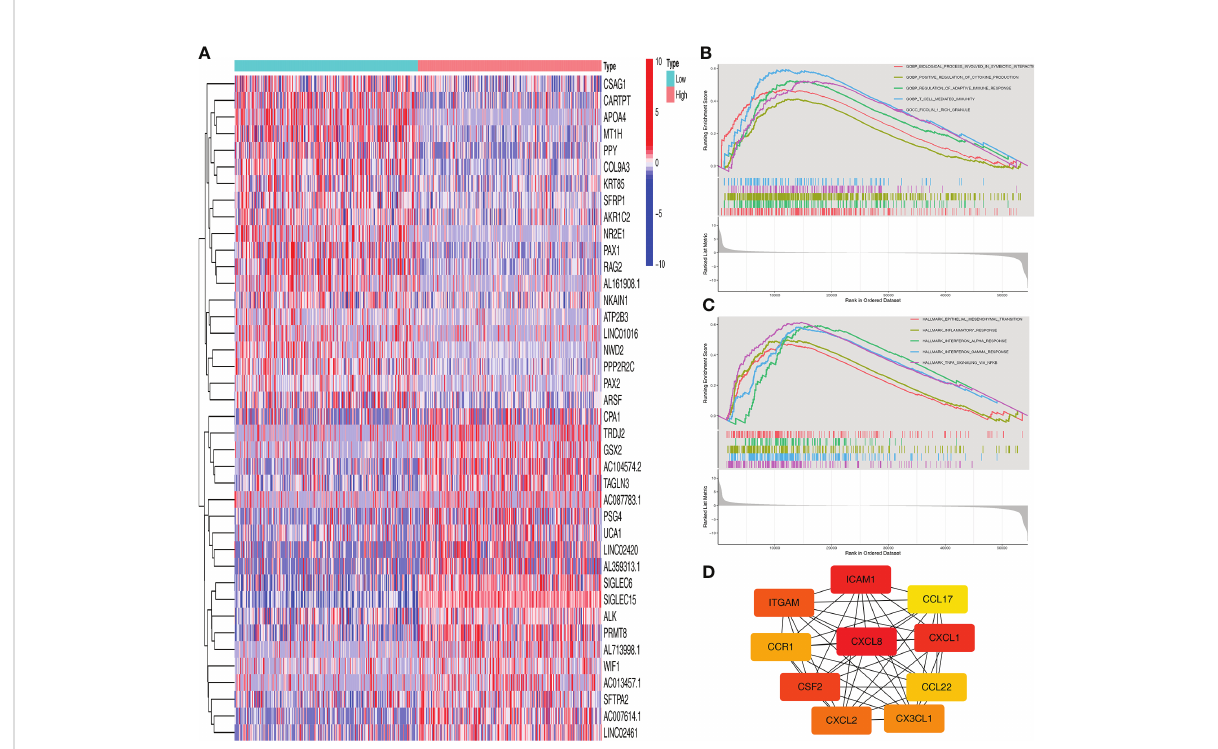
FIGURE 3 Functional enrichment analysis of SIGLEC15 . (A) Top 20 differentially expressed genes between high and low SIGLEC15 groups. (B, C) GSEA for the signaling pathways activated in the high SIGLEC15 mRNA expression group with (B) GO pathways and (C) HALLMARK pathways. (D) Hub genes related to SIGLEC15